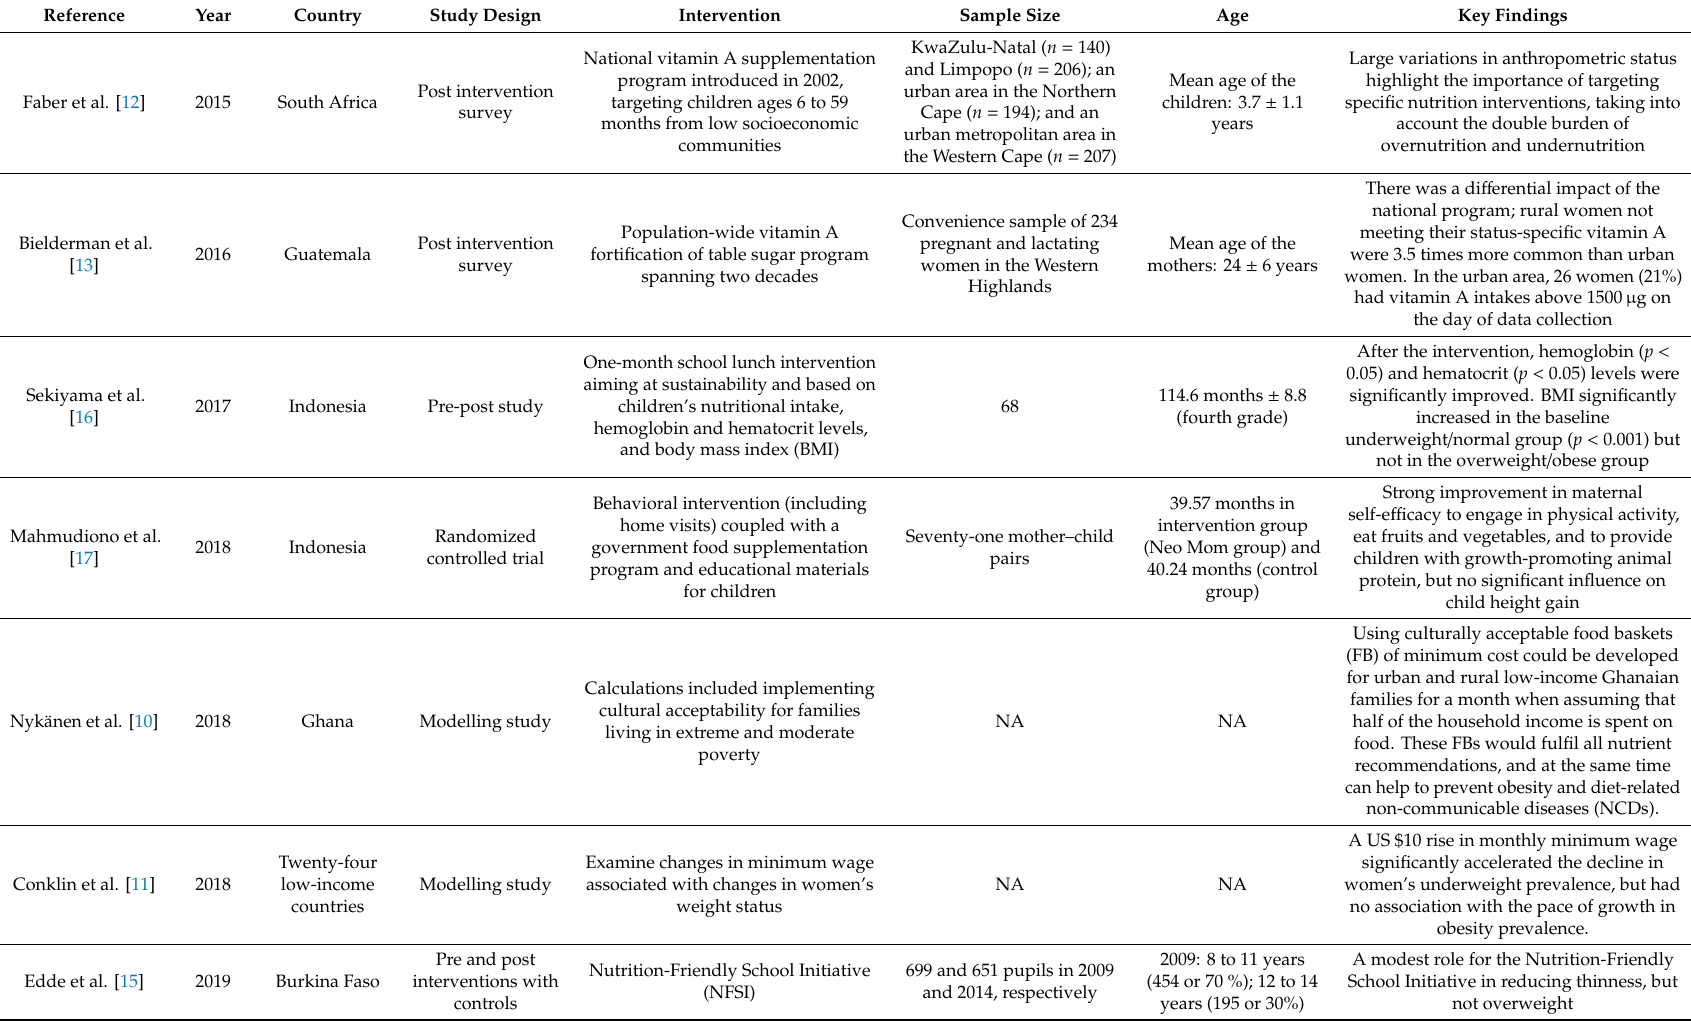
Table 2. Summary of the intervention or evaluation studies identified targeting the double burden of